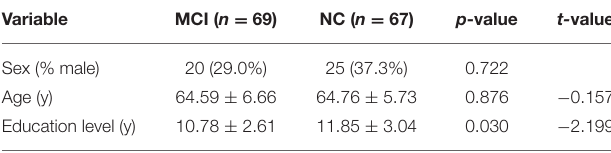
TABLE 1 | Descriptive data for the general characteristics ( N =